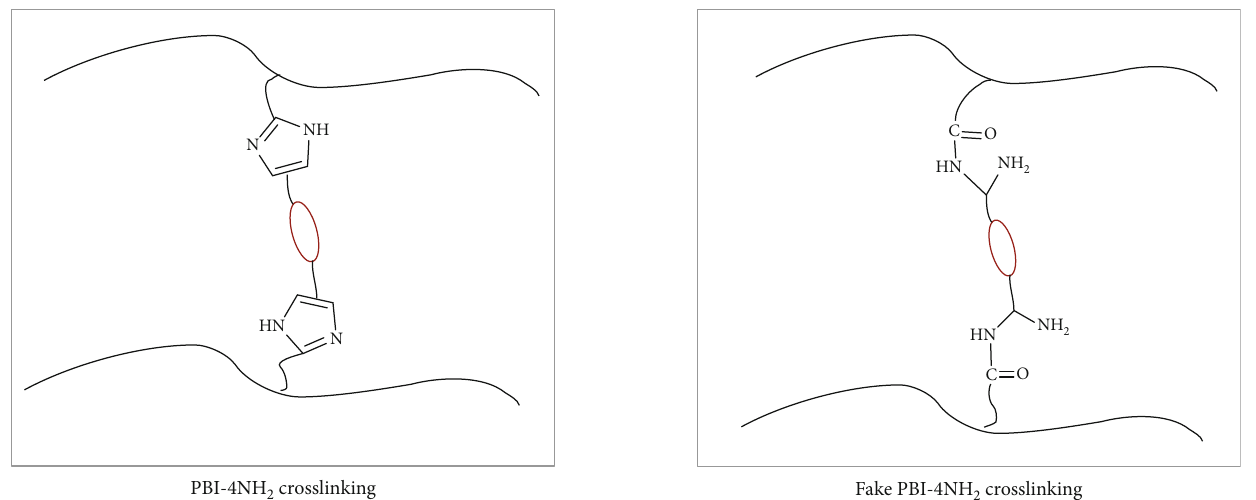
Figure 3: Schematic representation of the possible crosslinking structures of the PAEK- cr -PBI membrane.